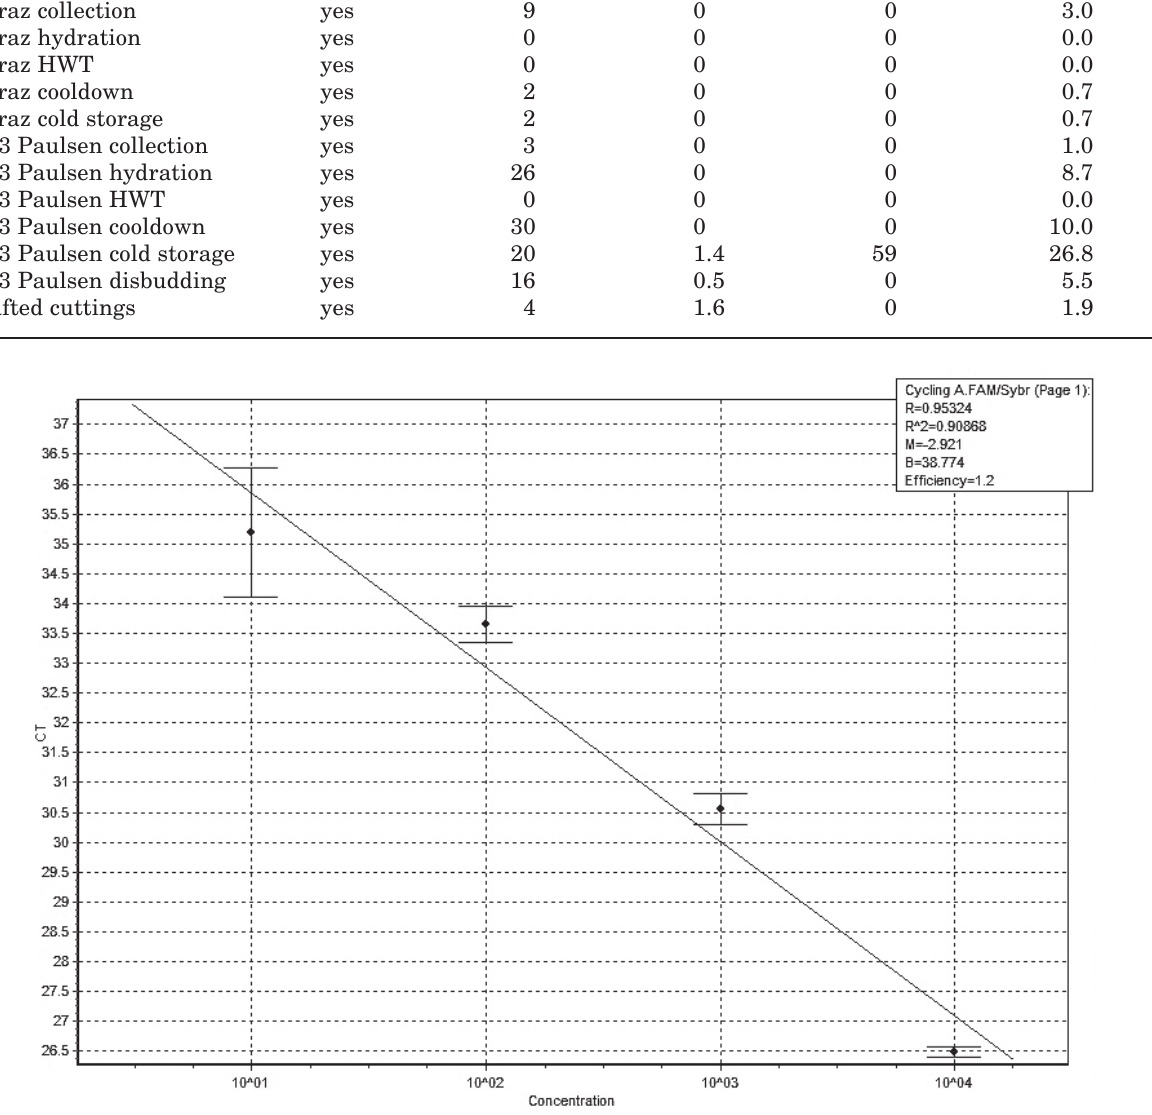
Fig. 2. 2003 sampling season: standard curve for the quantitative PCR (TaqMan ® ) assay of DNA samples from extracted water spiked with known amounts of P. chlamydospora (10 4 , 10 3 , 10 2 , 10, 1 spore ml -1 ) replicated 3